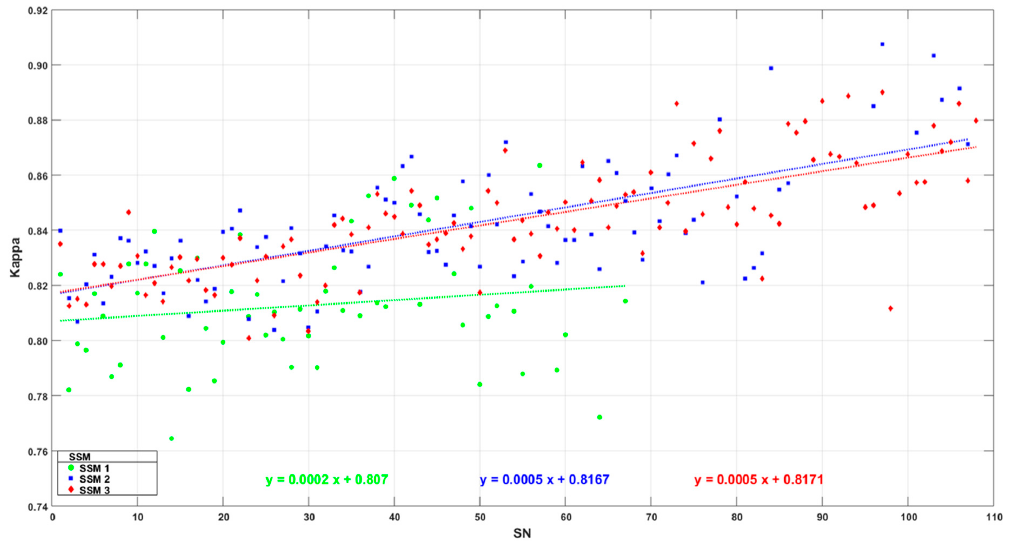
Figure 12. Kappa values according to segmentation numbers.